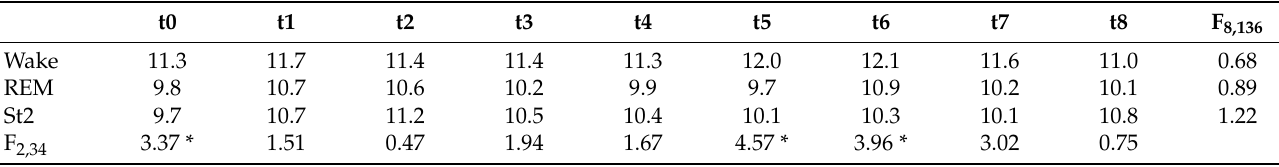
Table 3. Mean number of correctly recalled words in the episodic learning task for experimental conditions (wake, REM awakening, St2 awakening) and experimental trials (from t0 to t8). The last column shows the F values of ANOVAs within condition. The F values of ANOVAs within trial are reported in the last row.